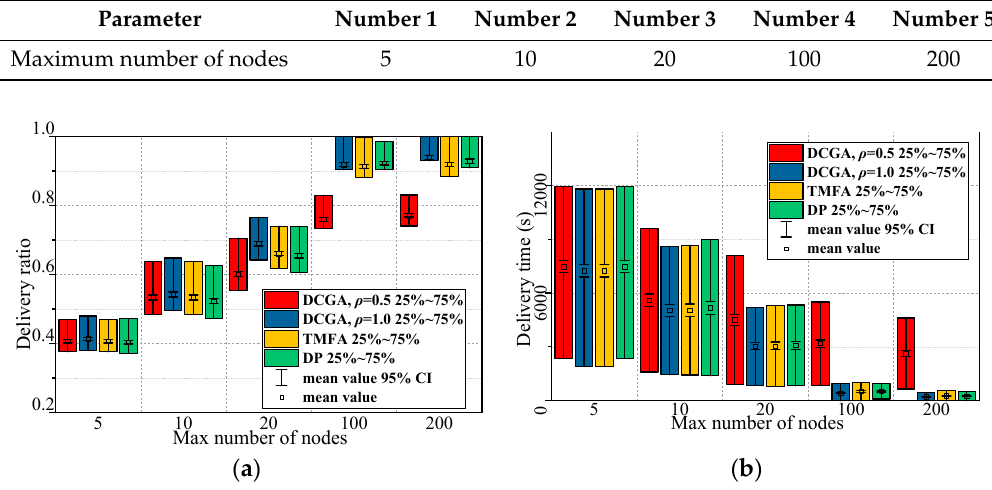
Table 4. Parameters of Scenario 3.